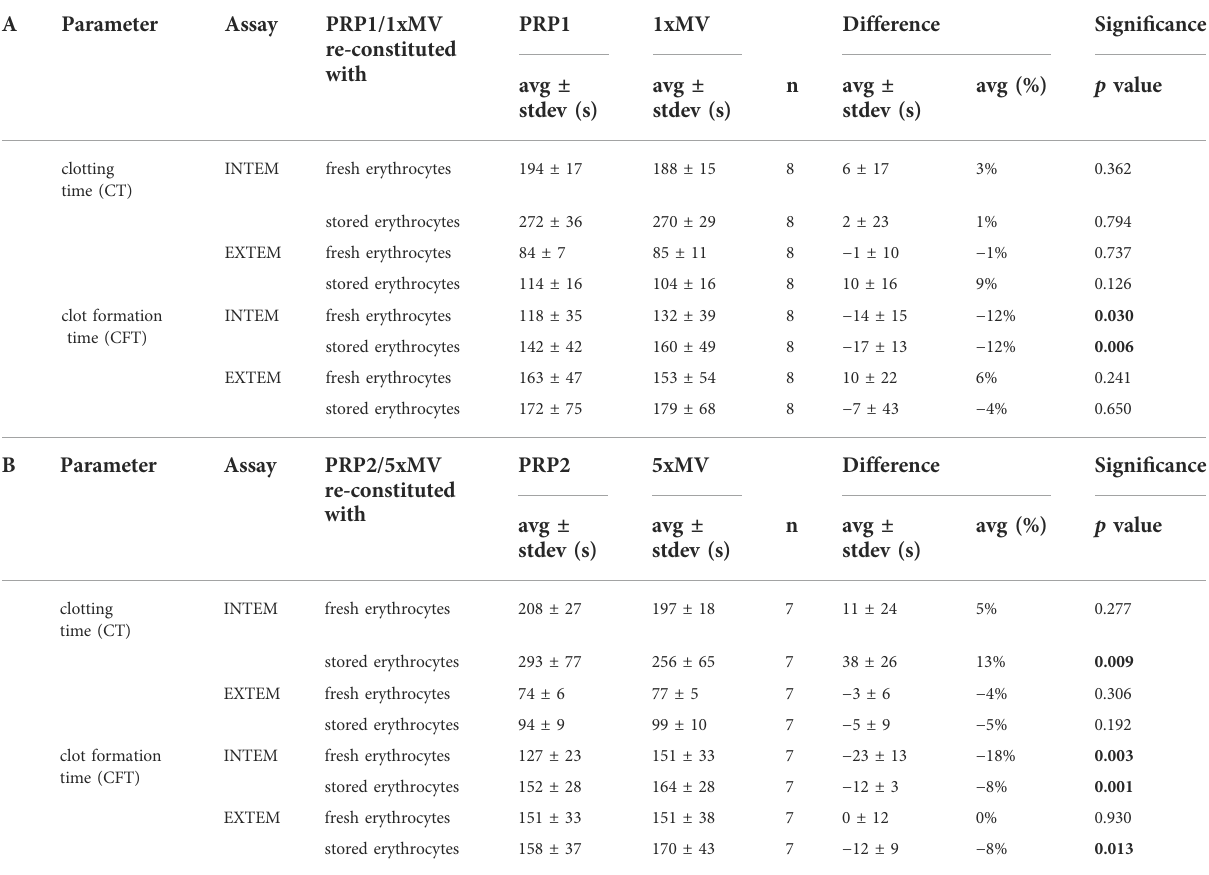
TABLE 3 Effects of vesicles from PRBC units on coagulability of reconstituted blood